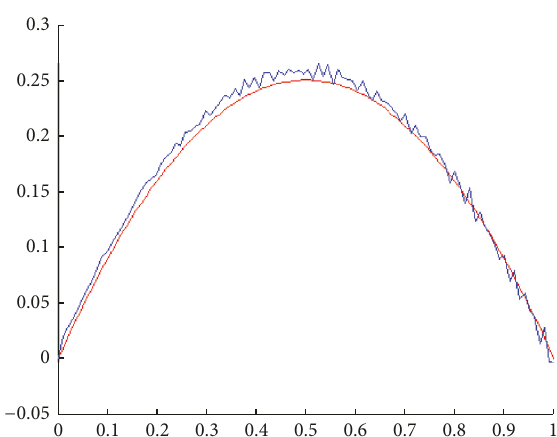
Iterations Figure 3: Graph of 𝐽 .